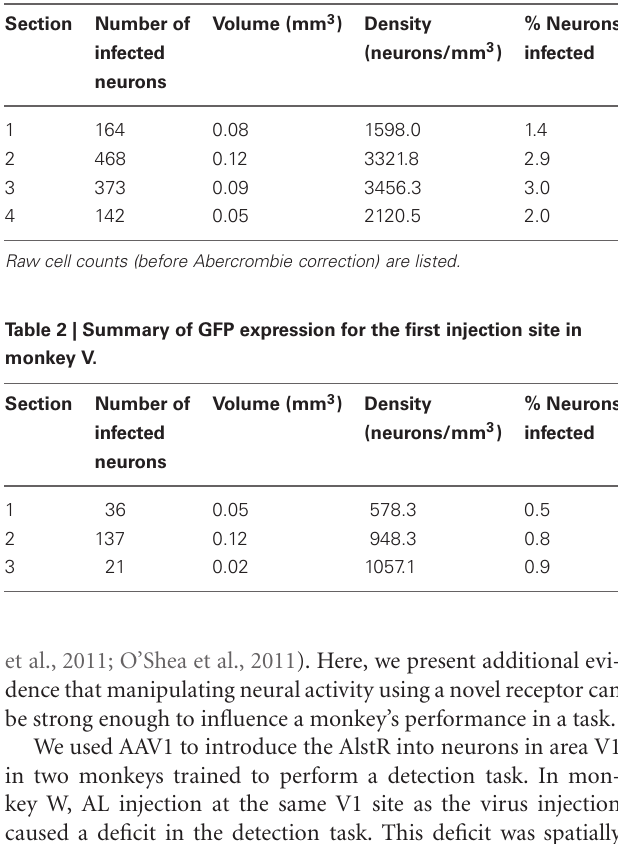
Table 1 | For each section from monkey W containing labeled neurons, the table lists the number of infected neurons, tissue volume containing labeled neurons, density, and fraction of infected neurons.